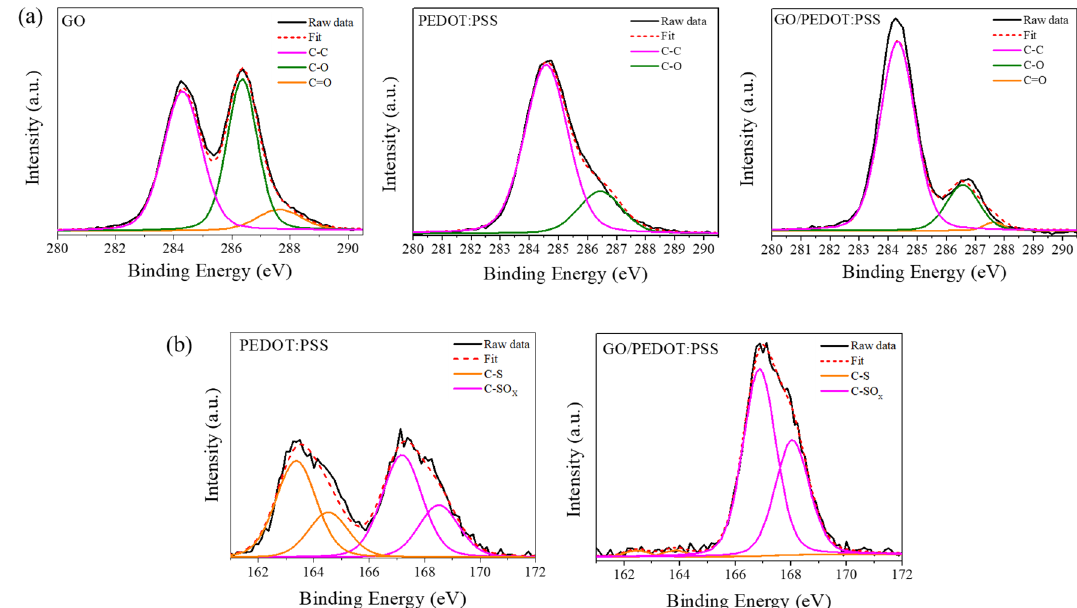
Figure 3. Comparison of the ( a ) C1s peaks of XPS spectra for GO, PEDOT:PSS, and GO/PEDOT:PSS composite; ( b ) Comparison of the S2p peaks for PEDOT:PSS and the GO/PEDOT:PSS